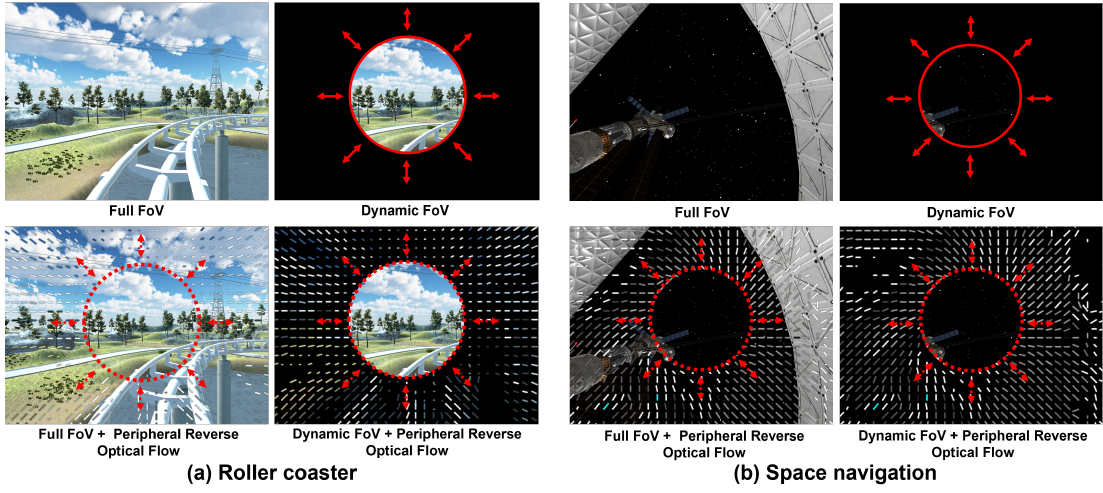
Figure 2. Four test conditions for assessing the effect of dynamically adjusted peripheral visualization of reverse optical flow for VR sickness reduction for the two test contents: ( a ) roller coaster and ( b ) space navigation. For each content, from top left, counterclockwise: full FoV, dynamic FoV [4], full FoV + peripheral reverse optical flow [3], and dynamic FoV + peripheral reverse optical flow. The dashed/solid lines indicate the peripheral boundary, and the arrows indicate the dynamic adjustment of the